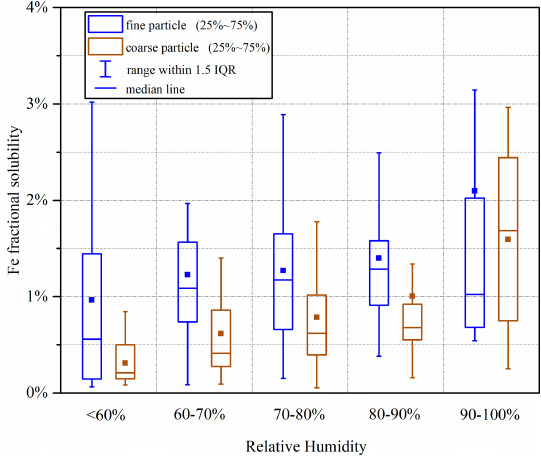
Figure 8. Fe solubility in different RH (relative humidity) ranges for fine and coarse particles (RH < 60%: 18d; 60% < RH <